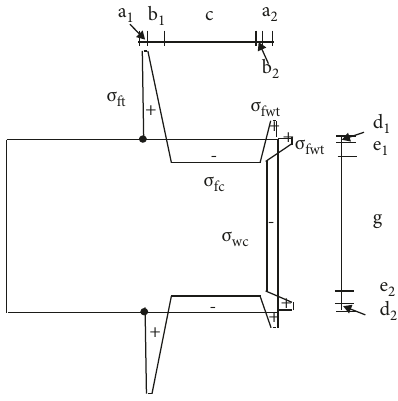
Figure 9: Residual stress